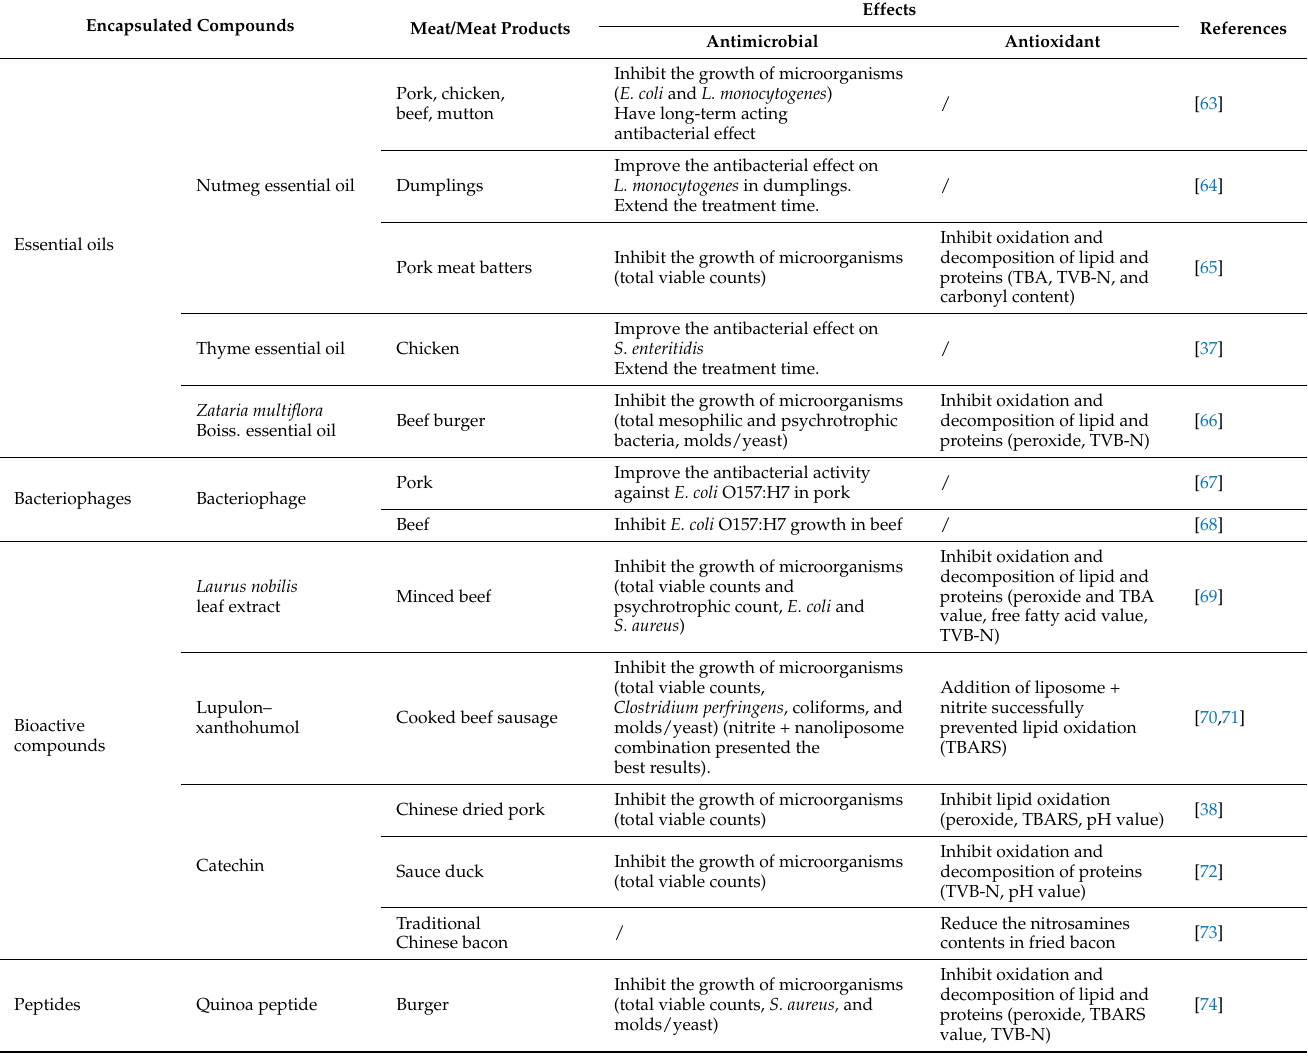
Table 2. Applications of encapsulated compounds in the meat